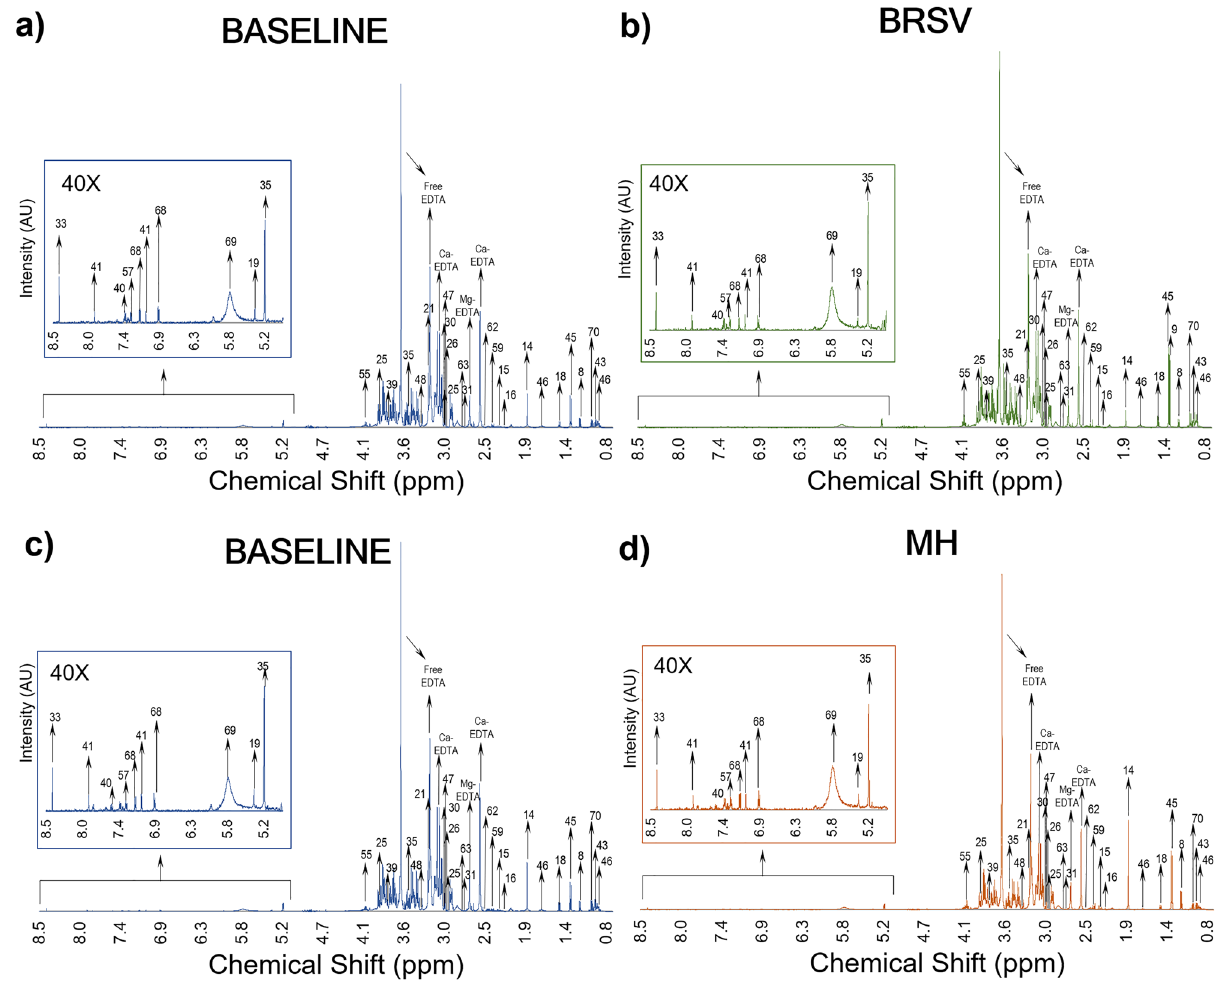
Figure 3. 1 H-NMR spectra (0.8–9.0 ppm) showing the peak intensities of metabolites present in plasma after the controlled infections with the main causal agents of BRD. ( a ) BRSV sample 66 (D0, calf 4), ( b ) BRSV sample 29 (D9, calf 4), ( c ) M. haemolytica (MH) sample 38 (D0, calf 6), ( d ) MH sample 2 (D2, calf 6). To improve the visualization of the peaks, the size of the region between 5.1–8.5 ppm was increased components gave a degree of optimization R 2 X = 0.80 and a cumulative prediction Q 2 = 0.38, with two outliers: samples 22 (D4, calf 2) and 34 (D11, calf 5). In the database composed of M. haemolytica samples (Fig. 5c), six principal components produced modeling parameters R 2 X = 0.79 and a Q 2 = 0.48. The outlier corresponded to Baseline sample 39 (D-2, calf 7). The OPLS-DA scores plots (Fig. 6) for the general (V + B) infection (Fig. 6a), BRSV (Fig. 6c), and M. haemo- lytica (Fig. 6e) databases demonstrated a clear distinction in the chemistry of plasma from non-infected and infected cattle. This suggests that even though the chemical composition of the plasma is similar before and after infection, as shown in the PCA scores plots (Fig. 5), there is enough information to successfully detect and dis- criminate infection from baseline with an accuracy, sensitivity, and specificity higher than 95% (Table 5). More importantly, all the models showed a specificity of 100%, meaning no false-positive samples (Baseline samples) were classified as infected. Table 5 shows the quality parameters for the calibrations and validations of each model using only two principal components (PCs). The values of R 2 X ( > 0.4), R 2 ( > 0.9), R 2 Y ( > 0.9), and Q 2 ( > 0.4)